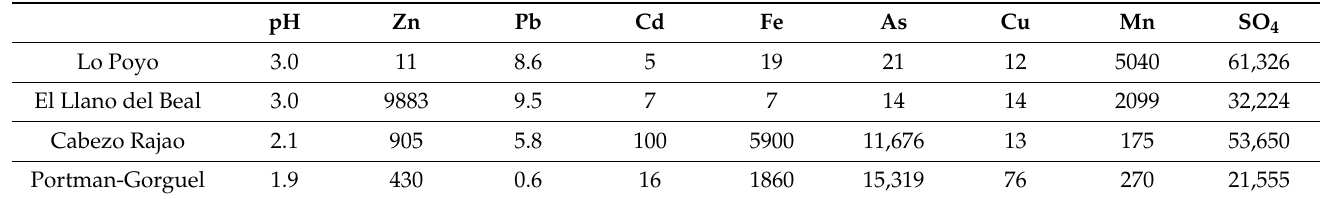
Table 4. Average concentrations of PTEs (mg/L, except As in µ g/L) in superficial water samples [28].